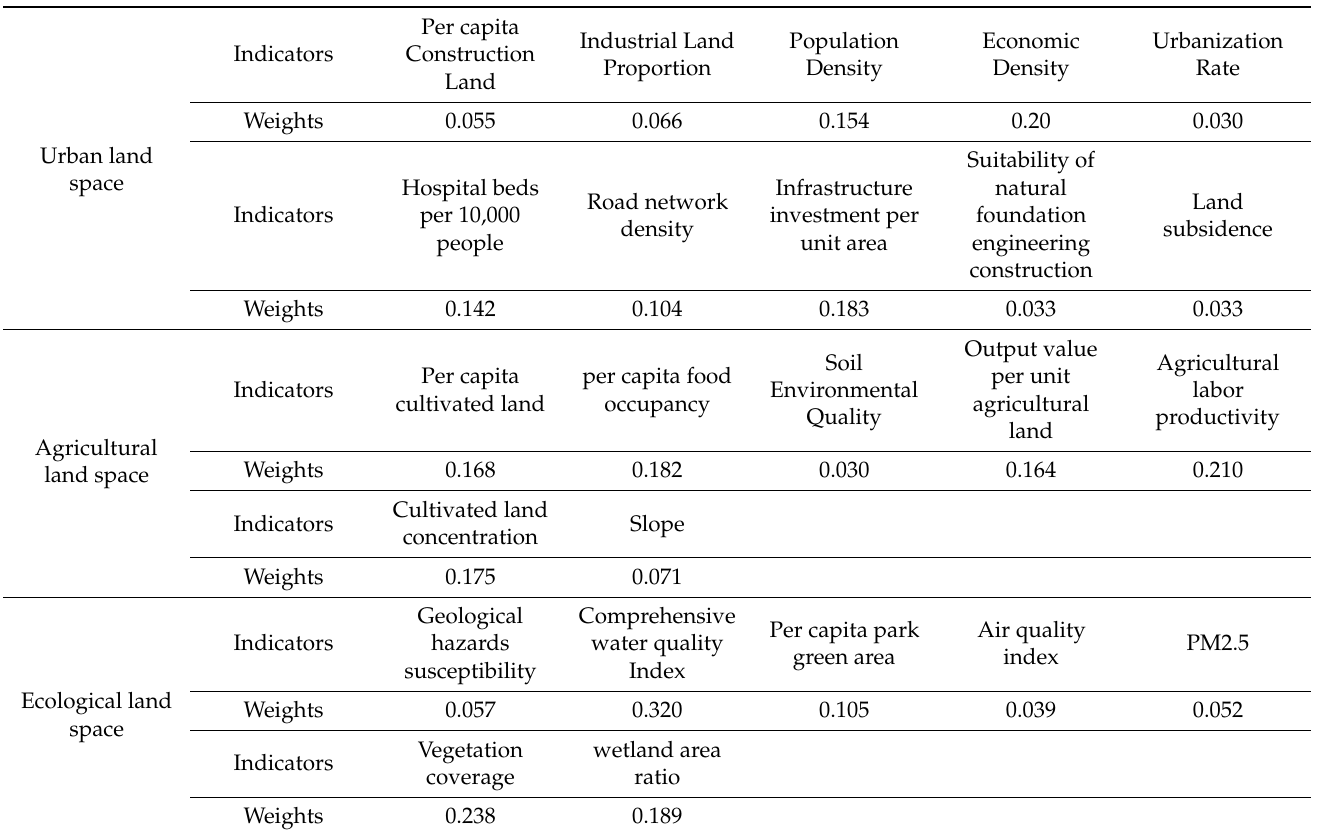
(Table 4). The selection basis for each land space evaluation indicator system is as follows: Table 4. Evaluation indicator systems for three subspaces and their